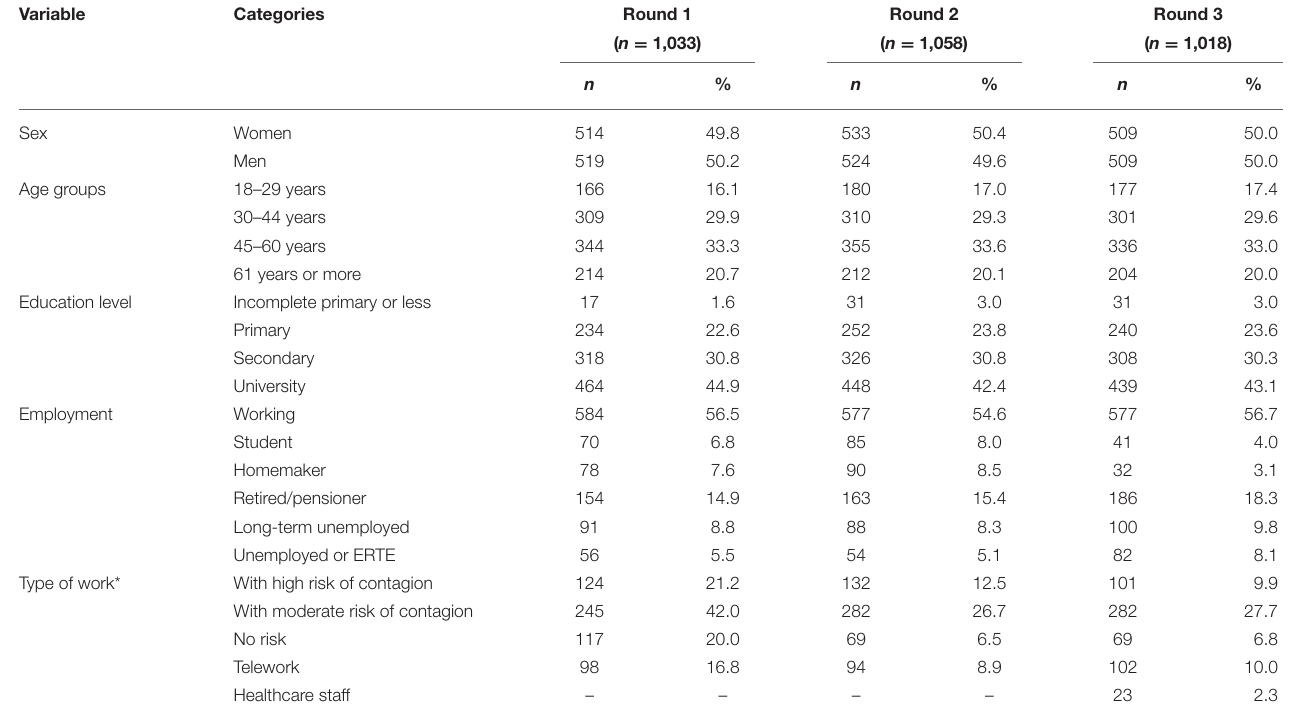
TABLE 1 | Socio-demographic characteristics of the samples in each round of the COSMO-Spain survey.